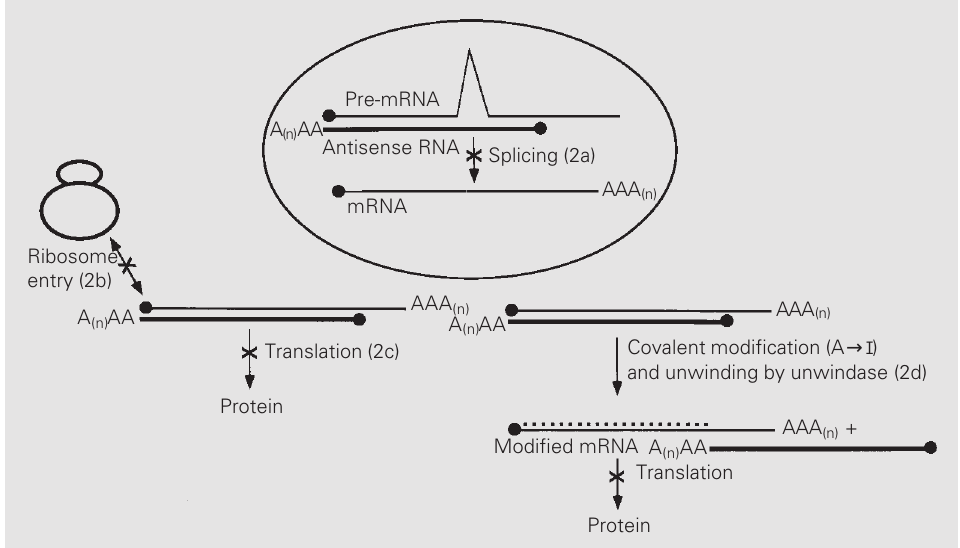
Figure 2 - Mechanisms of anti- sense RNA action. Antisense RNA covering two exons can in- hibit splicing of the target pre- mRNA in the nucleus (2a). In the cytoplasm it can inhibit ribosome binding to the cap structure (closed circle) and the 5'-un- translated part of the mRNA (2b) or it can block the elongation of the nascent protein chain (2c). In addition, the extended double- stranded RNA formed by the an- tisense RNA and its target mRNA represent a substrate for double-stranded RNA editing en- zymes (unwindase), which mod- ify both RNAs by deaminating adenosine residues (21). The re- sulting inosine bases form base pairs with guanine leading to the synthesis of mutated proteins from such altered mRNAs